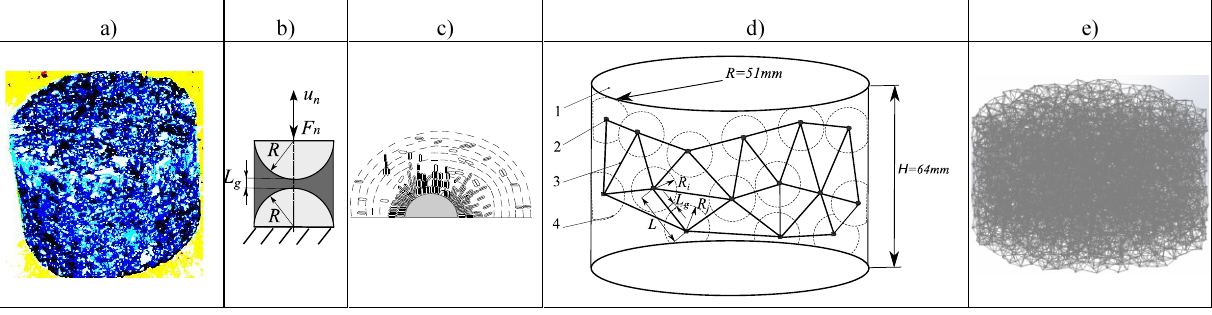
Fig. 2. Illustration of the modelling strategy, where: a) asphalt specimen of Marshall test; b) model of two particles with basic geometrical parameters; c) heterogeneity of binder; d) DE model with basic parameters; e) numerical model of the asphalt